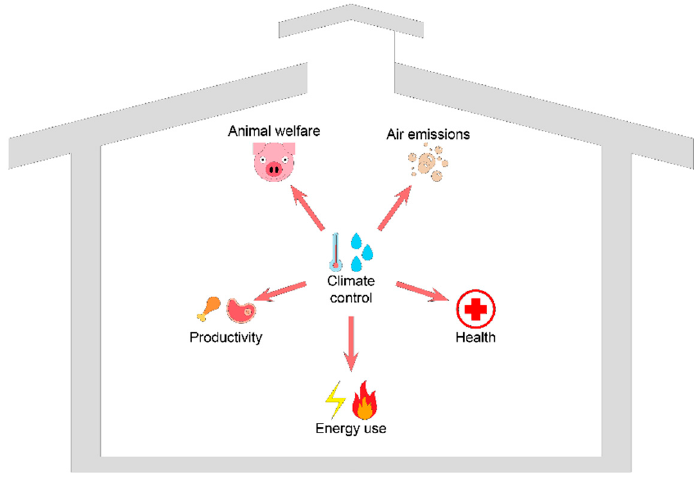
Figure 2. Conceptualization of the relations between climate control and the considered domains of livestock production.